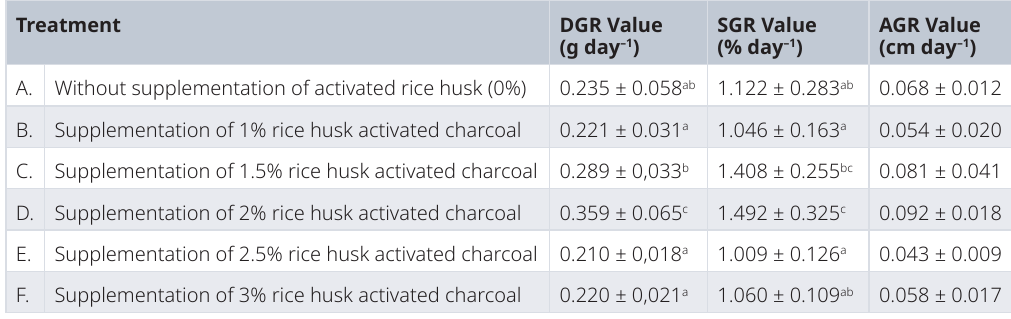
Table 2. Daily growth rate (DGR) specific growth rate (SGR), and absolute growth rate (AGR) of juvenile of giant trevally ( Caranx ignobilis ).